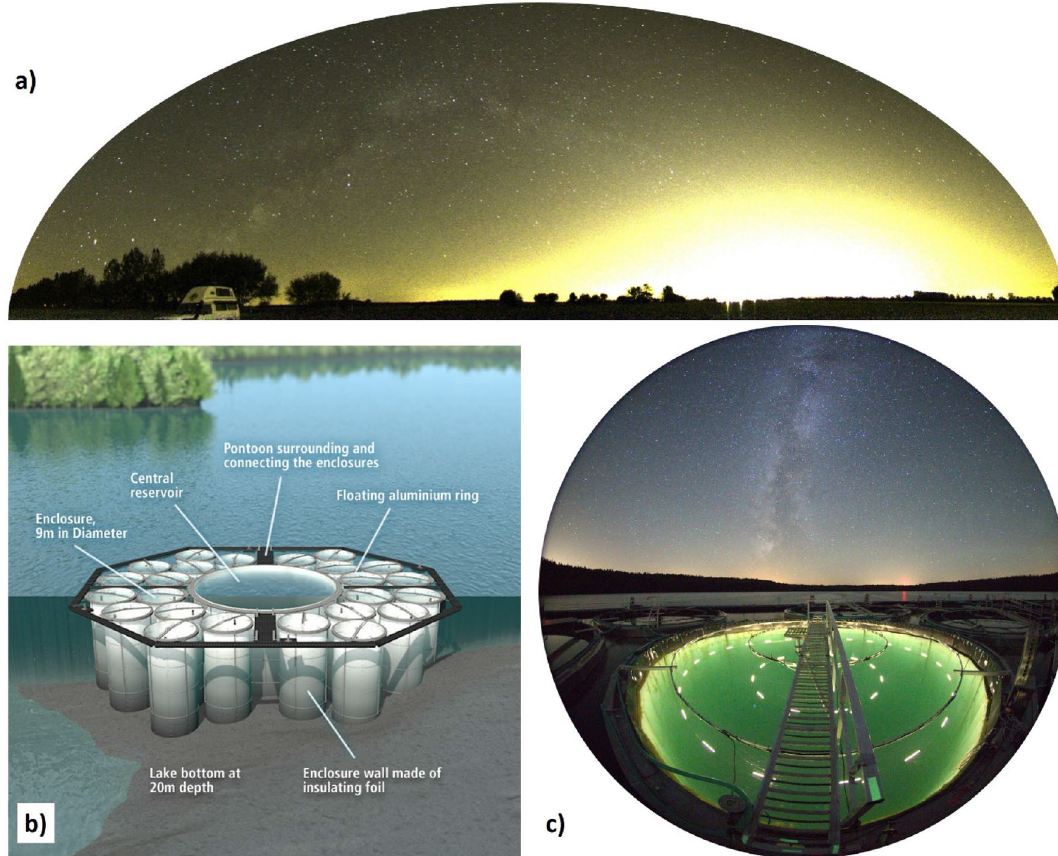
Figure 1. The skyglow illumination system. ( a ) Panoramic image of the skyglow above the city of Berlin, Germany, viewed from 30 km distance obtained from an all-sky image. This image was not taken at the experimental site and serves for illustration purpose of the phenomenon of skyglow. (image credit: A. Jechow) ( b ) Sketch of the enclosure facility, LakeLab, in Lake Stechlin, Germany (image credit IGB, www. lake- lab. de). ( c ) Skyglow system illuminating one of the enclosures of Lake Lab. The Milky Way and weak skyglow from small towns at the horizon are visible in the background. The green appearance of the water results from backscattering of the LED light. (image credit: A.